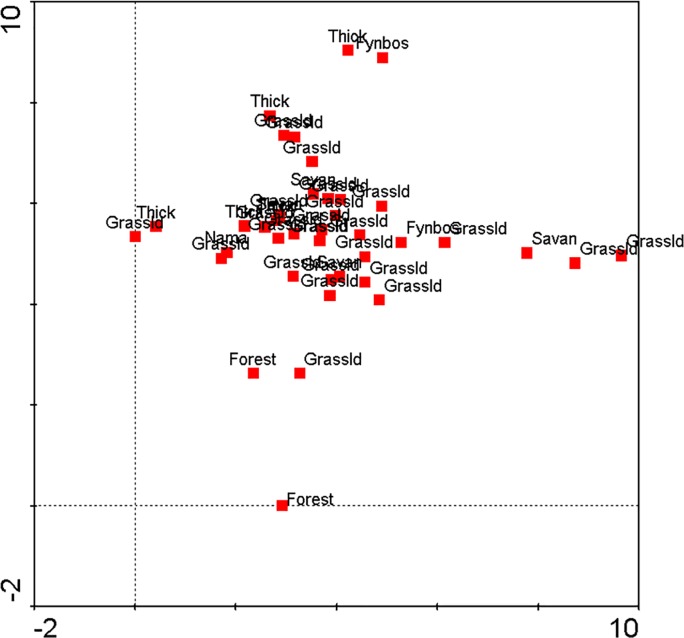
Principle components analysis scatter plot of the biome of the 48 sample towns based on the species composition of the street names.